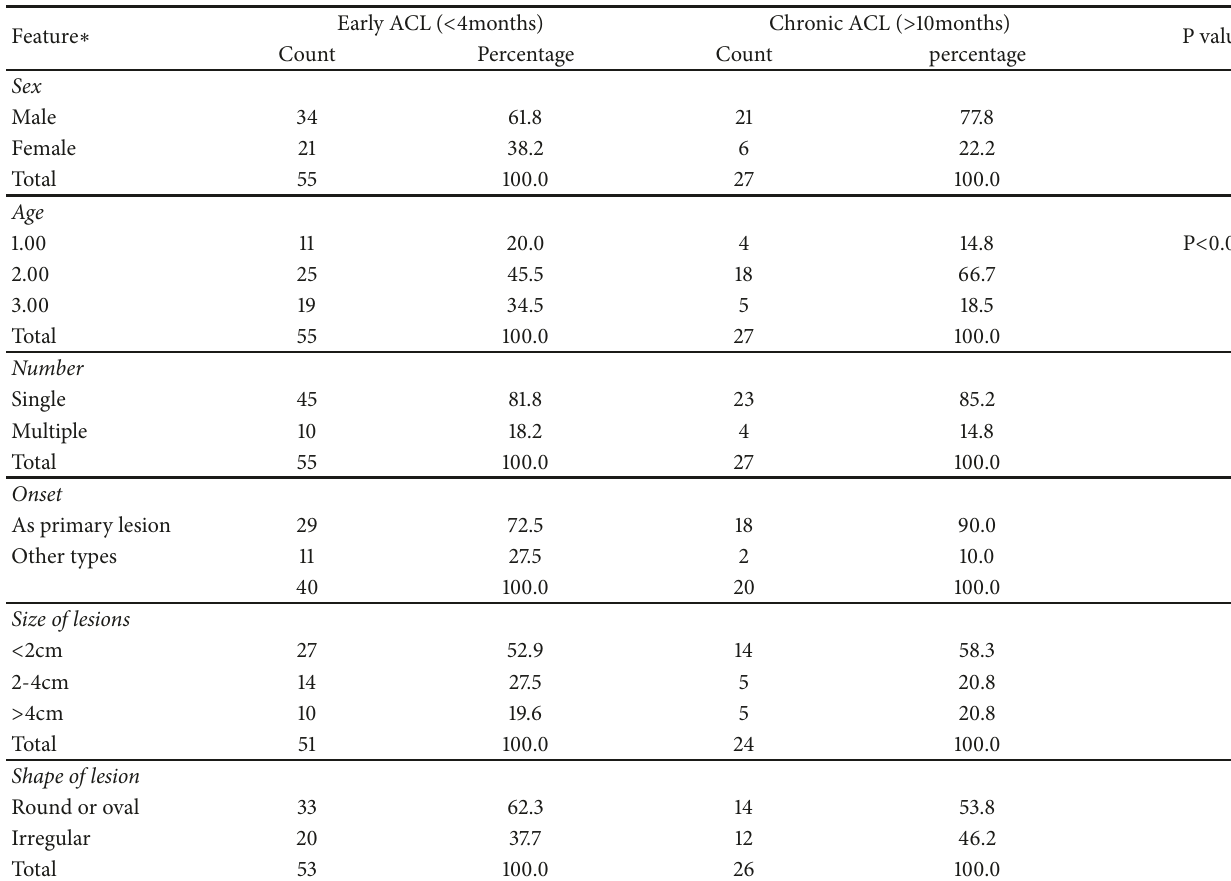
Table 3: Sociodemographic and clinical trends during development of ACL.